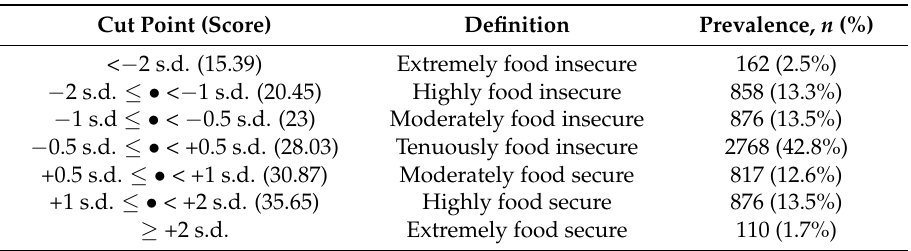
Table 8. Food security cut